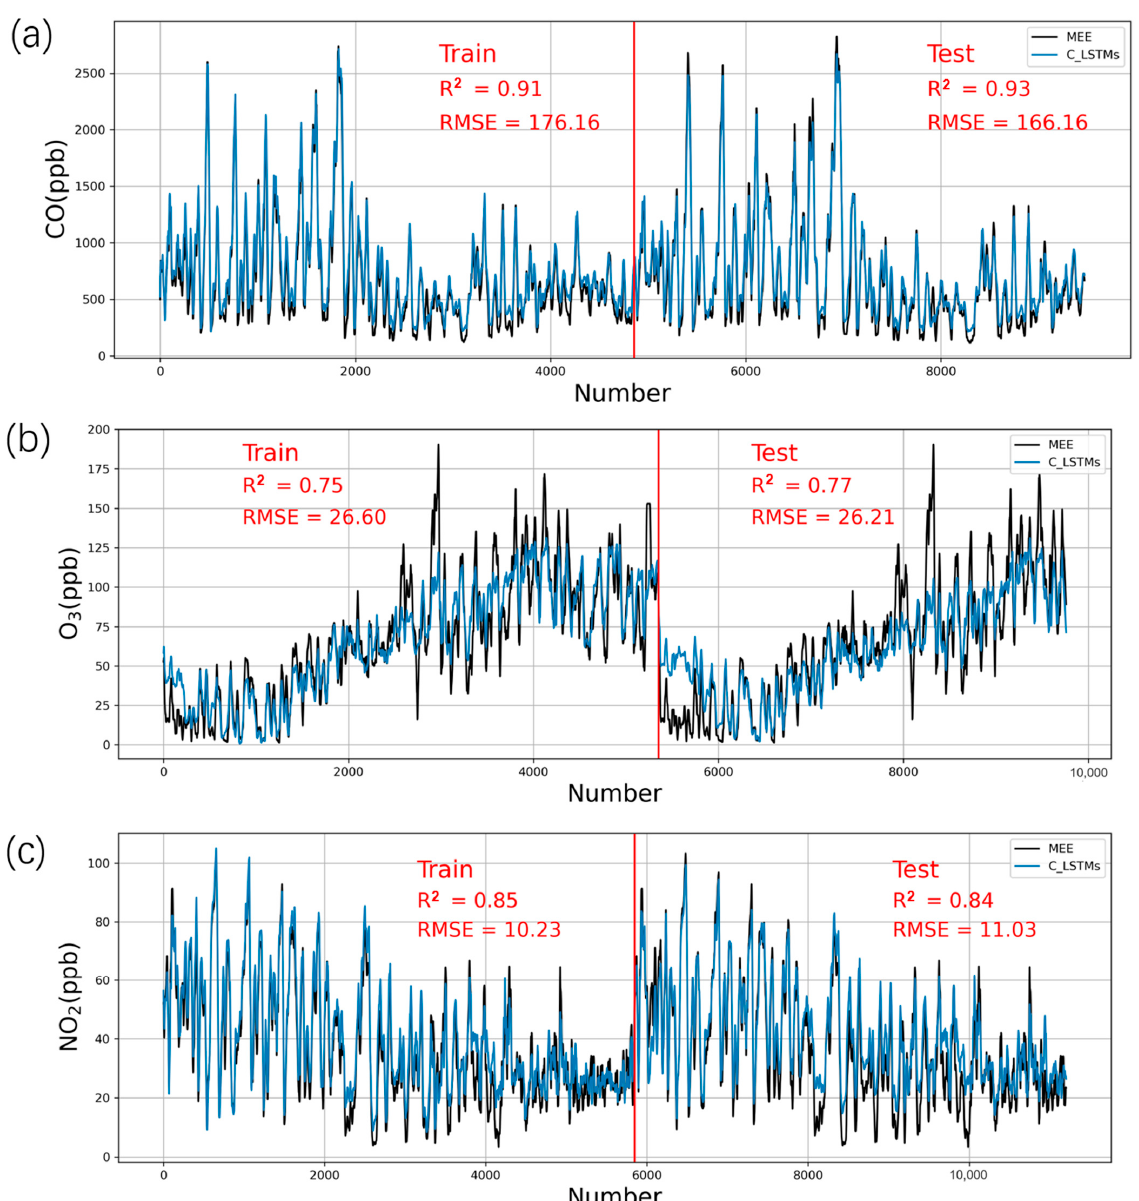
Figure 4. Training and testing of sensors using the long short-term memory (LSTM) method and comparison with MEE data from the reference instruments based on a 24 h rolling average. ( a ) CO, ( b ) O 3 , and ( c ) NO 2 . One set of sensors in Model 1 is the training data, and the other set of sensors in Model 2 is the testing data.